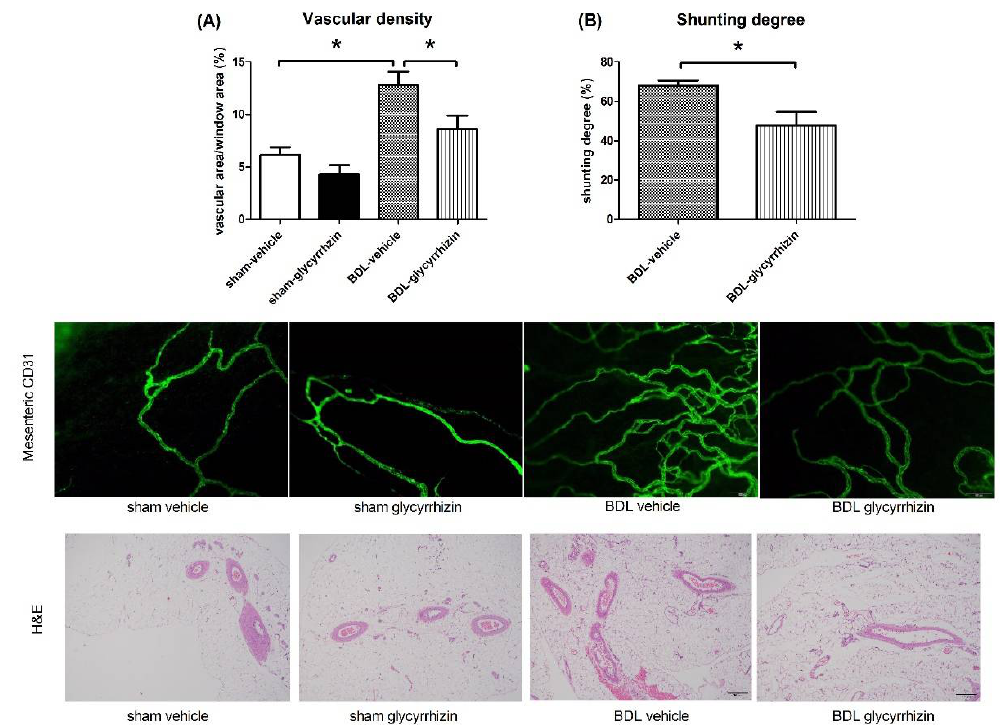
Figure 3. Effects of glycyrrhizin on mesenteric angiogenesis and portal-systemic collateral shunting. ( A ) Mesenteric angiogenesis was evaluated by vascular density of mesenteric window. In cirrhotic rats, the mesenteric vascular density was markedly higher than sham rats. Glycyrrhizin significantly reduced mesenteric vascular density ( n = 5, 6, 6, 6). ( B ) The shunting degree was evaluated by color microsphere method. The shunting degree was significantly decreased in glycyrrhizin-treated group ( n = 7, 7). Scale bar = 200 μm. * p < 0.05